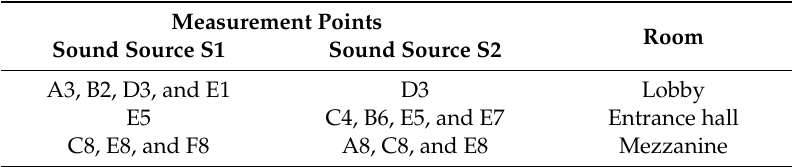
Table 6. Measurement points of the reverberation time.